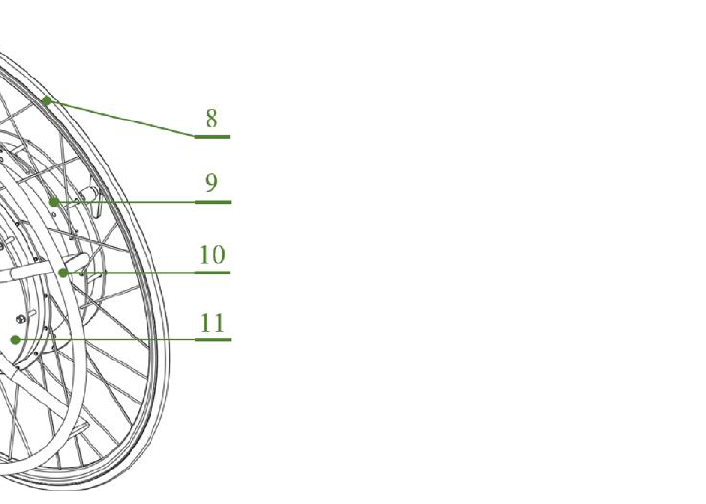
Figure 1. View of the assembled system: 8—tire, 9—system of spokes mounted to the hub flange, 10—handrims and 11—internal gear hub.